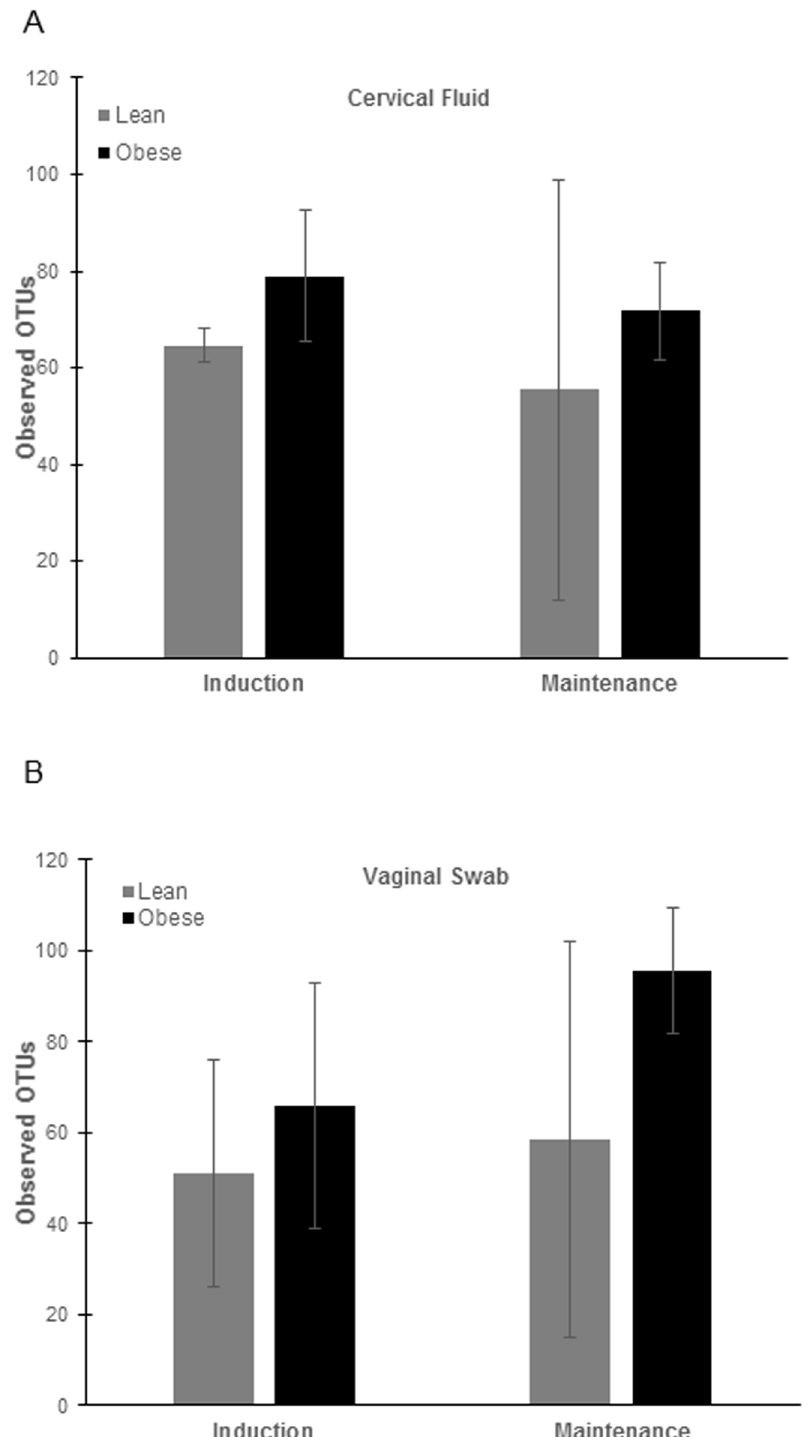
Fig 4. Alpha-diversity on number of OTUs observed. Results are expressedas least squared mean ± SEM (control, n = 3; obese, n = 2).